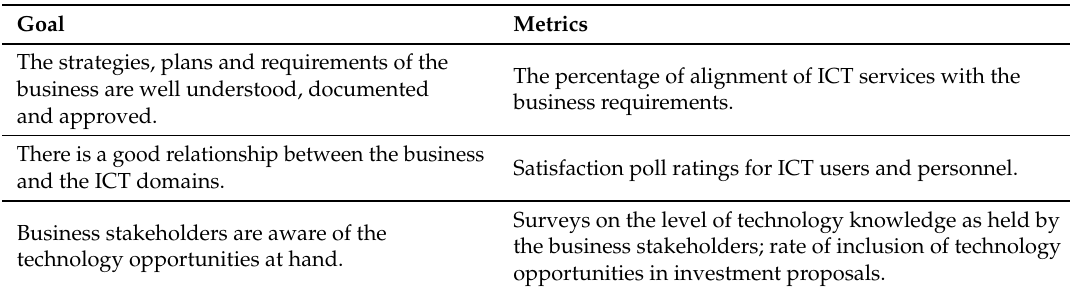
Table 1. Objectives and metrics APO008